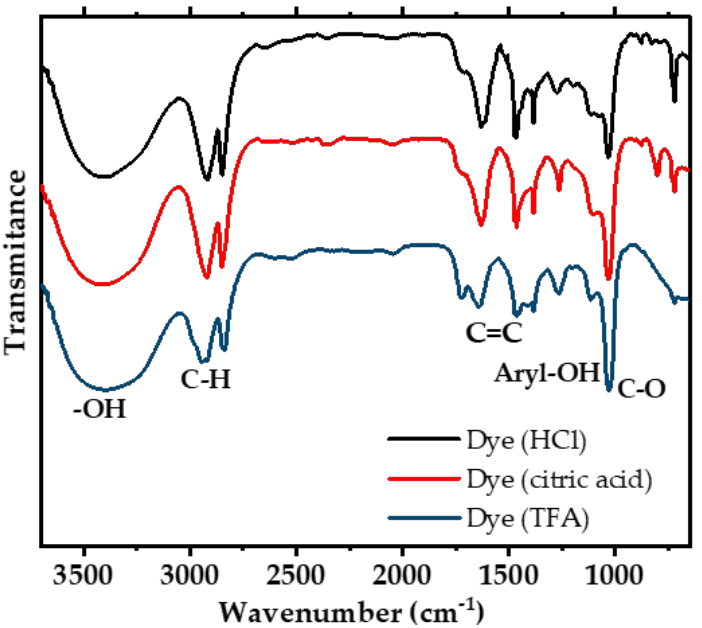
Figure 2. FT-IR spectra of purified anthocyanin extracts.